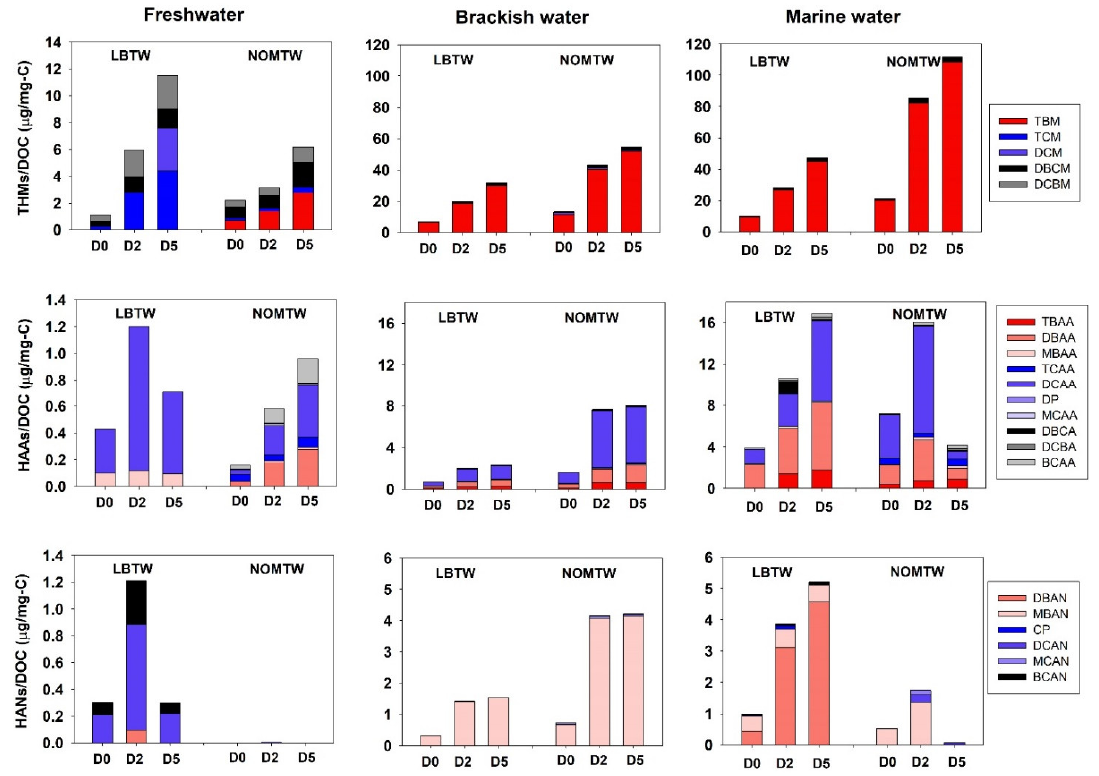
Figure 2. DBP concentration divided by DOC concentration on Days 0, 2, and 5 for both land-based test water (LBTW) and algal organic matter test water (AOMTW) categorized as fresh, brackish, and marine.